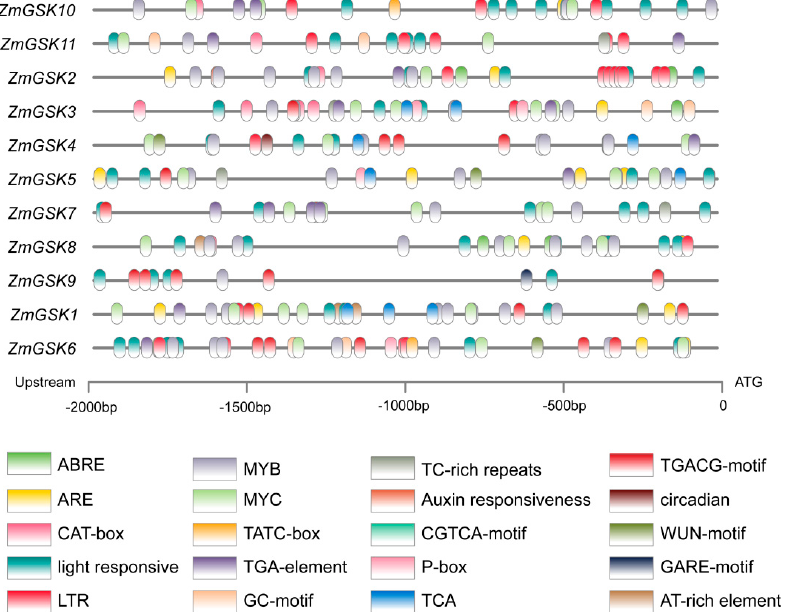
Figure 4. Predicted cis-acting regulatory elements in the promoter regions of GSK genes. Promoter